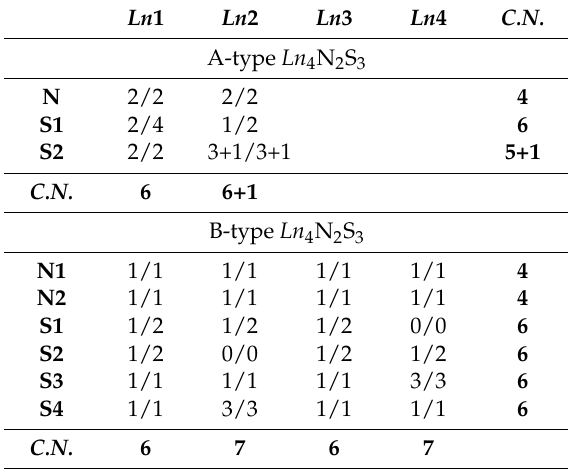
Figure 4. Projection of the crystal structure of the A-type Ln 4 N 2 S 3 series ( Ln = La–Nd) on the [001] plane. Table 5. Motifs of mutual adjunction for the A- and B-type Ln 4 N 2 S 3 structures ( Ln = La–Nd).